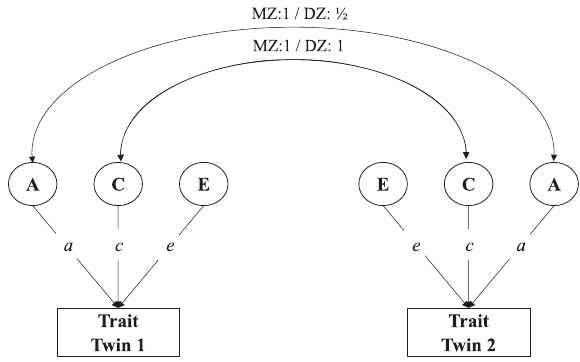
Fig. 3 Classical twin design. The variance in a trait is decomposed into additive genetic (labeled A ), shared environmental ( C ), and non- shared environmental in fl uences ( E ) by using the difference in genetic relatedness between monozygotic (MZ) and dizygotic (DZ) twin